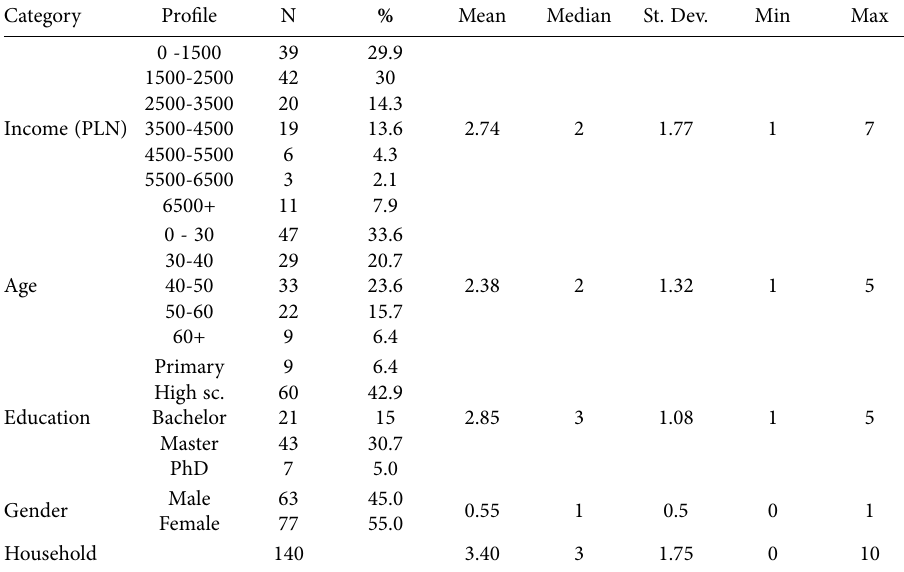
Table 1. Socio-demographic characteristics of the respondents.